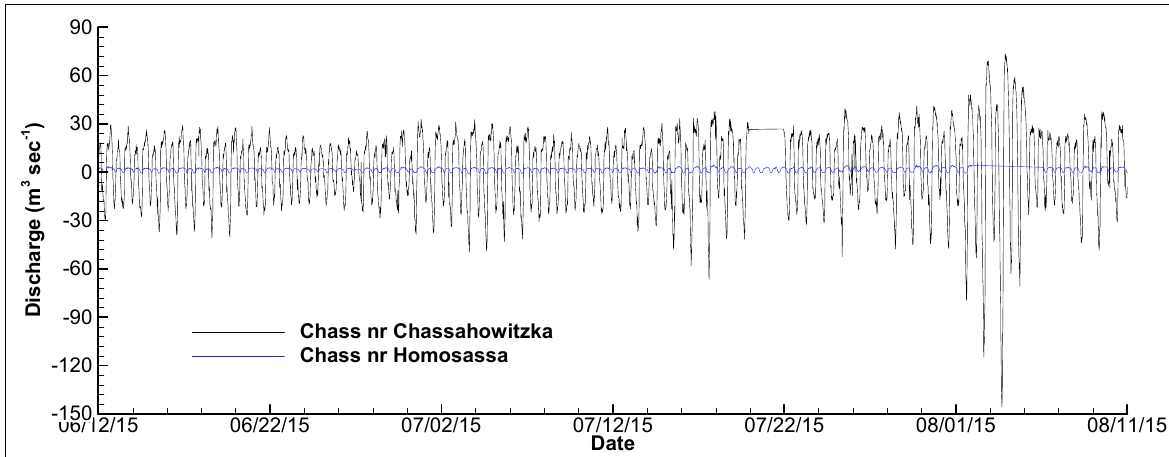
Figure 4. Measured cross-sectional discharges at the CRH (blue line) and CRC (black line) stations in